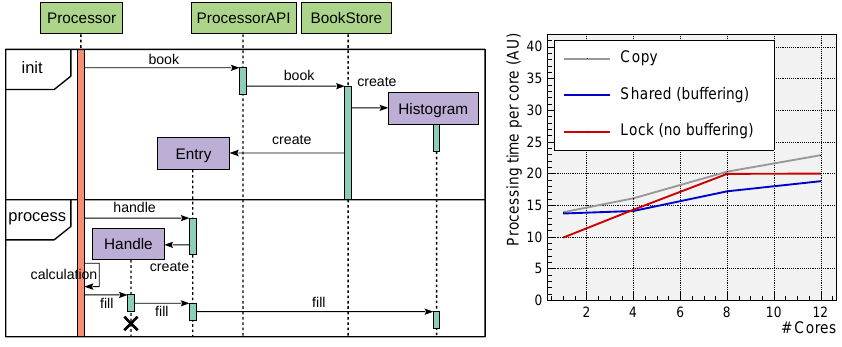
Figure 4. Left: UML sequence diagram of the BookStore component. Right: Performance comparison for the three types of handling the histograms for 1000 histograms with 1000 bins each as a function of the number of cores